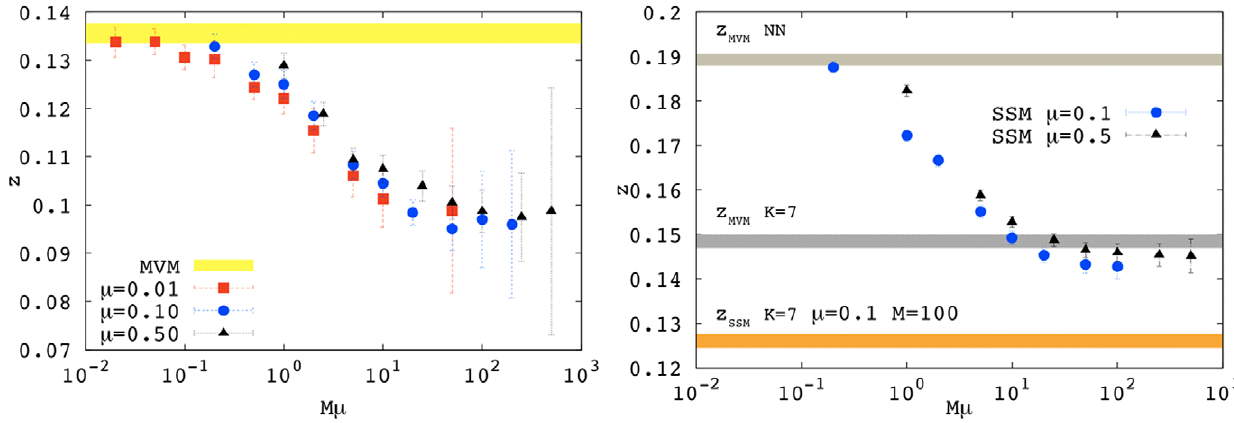
Figure 3. Exponent z for the SSM as a function of M m at fixed (cid:2) nn ~ n = m . The left panel shows the case (cid:2) nn ~ n = m ~ 10 { 8 for m ~ 0 : 5,0 : 1,0 : 01 with (including the estimated error) of the exponent for the MVM with n ~ 10 { 8 . For M m & 1 statistical NN-kernel. The shaded area indicates the value z MVM errors increase because a smaller number of realizations was used as simulations become very costly. The right panel shows the case (cid:2) nn ~ n = m ~ 10 { 6 for m ~ 0 : 5,0 : 1 with NN-kernel. The shaded areas display the value of the exponent for the MVM with both the NN- and square-kernel ( K =7) and the SSM with square-kernel ( K =7) for M =100 and m ~ 0 : 1 (i.e. M m ~ 0 : 1 ).